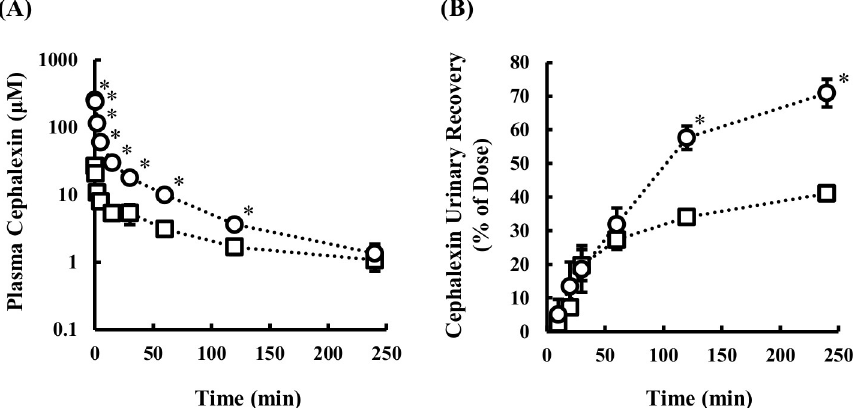
Fig 4. Plasma concentration-time profile (A) and cumulative urinary excretion (B) of cephalexin after administration of high (10 mg/kg, circles) and low (1 mg/kg, squares) doses. Concentrations of cephalexin in plasma and urine were measured up to 4 h after intravenous administration of cephalexin. Data are presented as mean ± SEM (n = 3). � p < 0.05 vs. 1 mg/kg dose